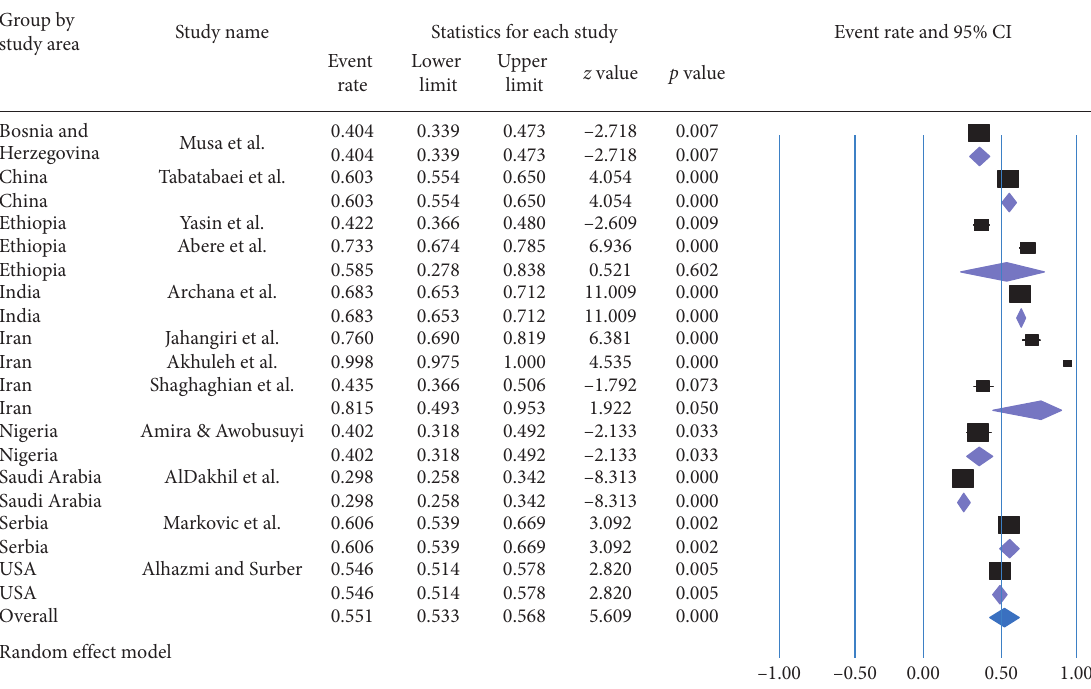
Group by study area